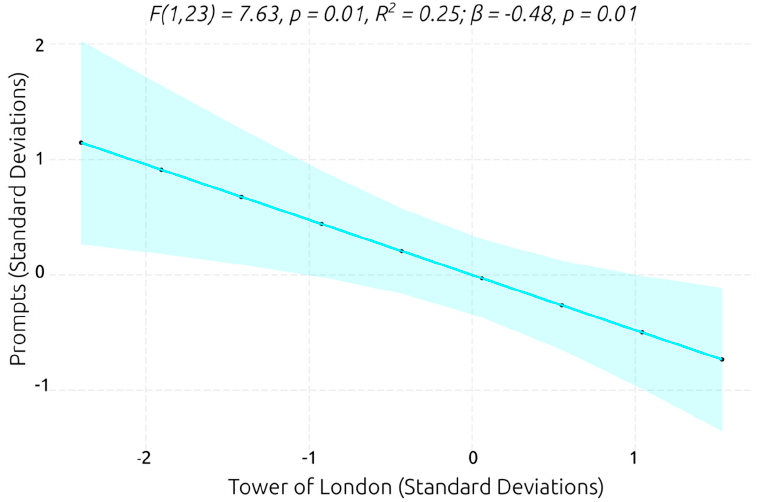
Figure 11. Best linear regression model for predicting prompt number.